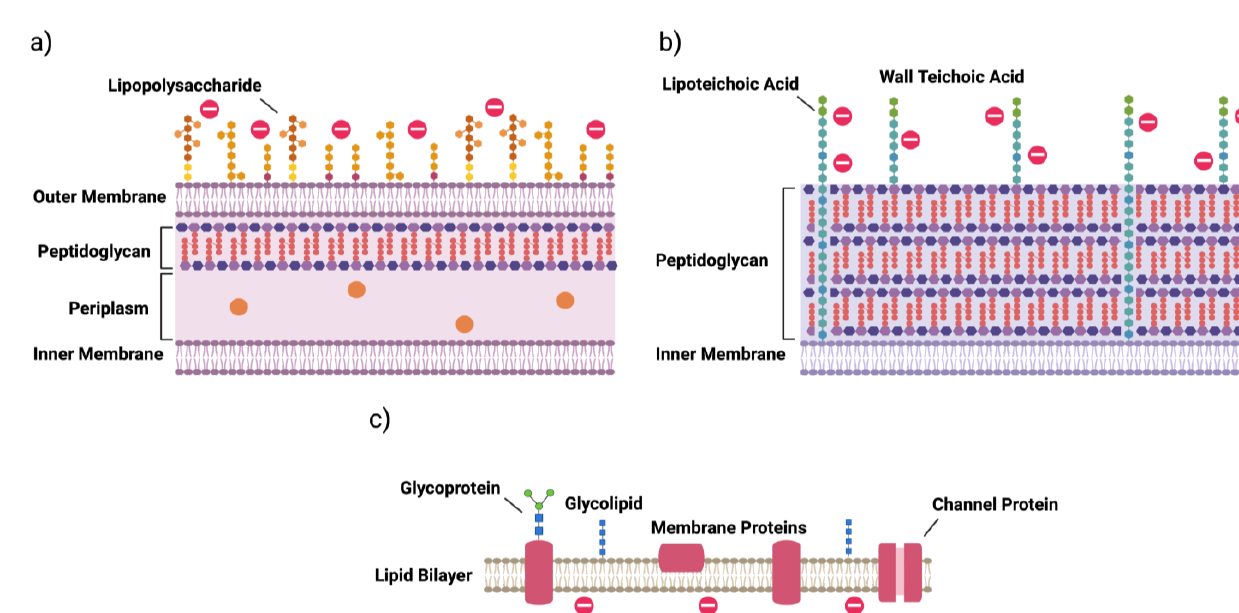
Figure 1. Structures of ( a ) Gram-negative bacterial cell walls; ( b ) Gram-positive bacterial cell walls; and ( c ) mammalian cell membranes.